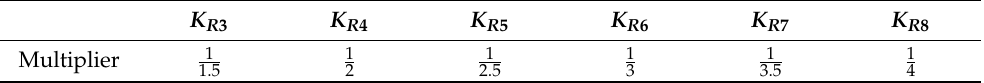
Table 1. Support member radial stiffness factor for multi-point support mode.